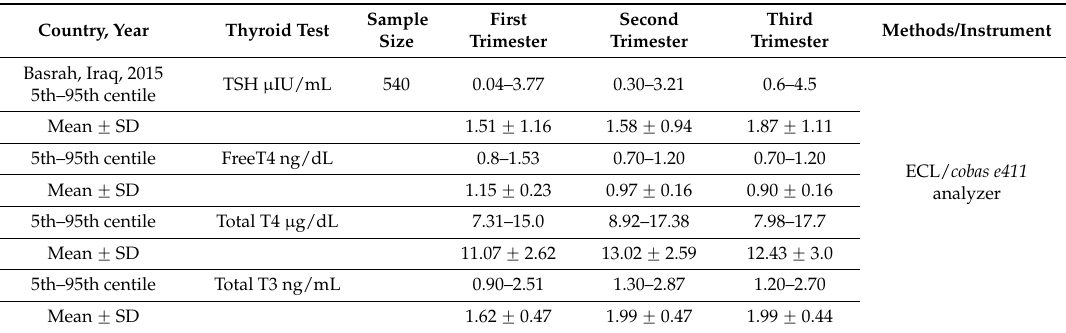
Table 5. Comparison between different countries in the Trimester specific reference